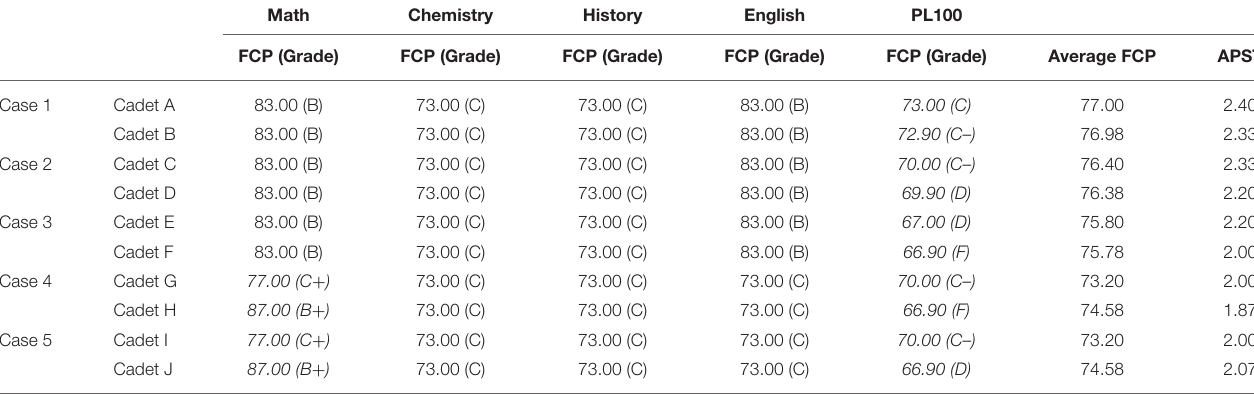
TABLE 3 | Final course percentages and APSTs for five case